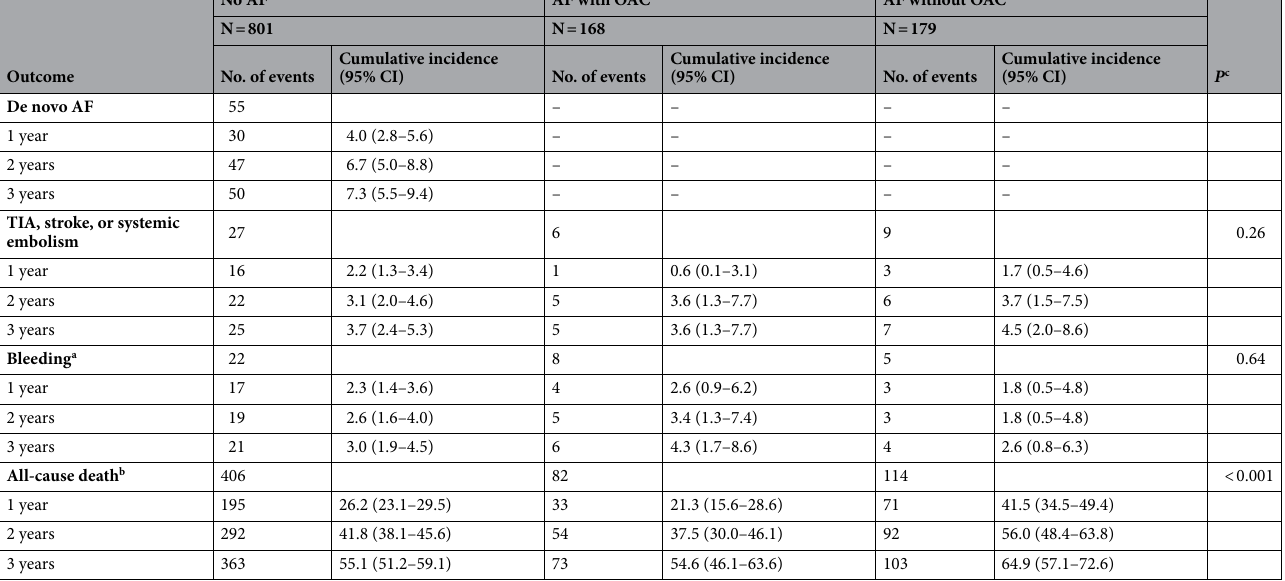
Table 3. Number of events and cumulative incidence during follow-up. AF, atrial fibrillation; CI, confidence interval; N, number of patients; No., number; OAC, oral anticoagulation; TIA, transient ischemic attack. a Intracranial bleeding, gastrointestinal bleeding, or other clinical relevant extracranial bleeding. b 1-Kaplan– Meier estimate. c Univariable competing risk regression model (cause-specific hazard model); AF with OAC versus AF without